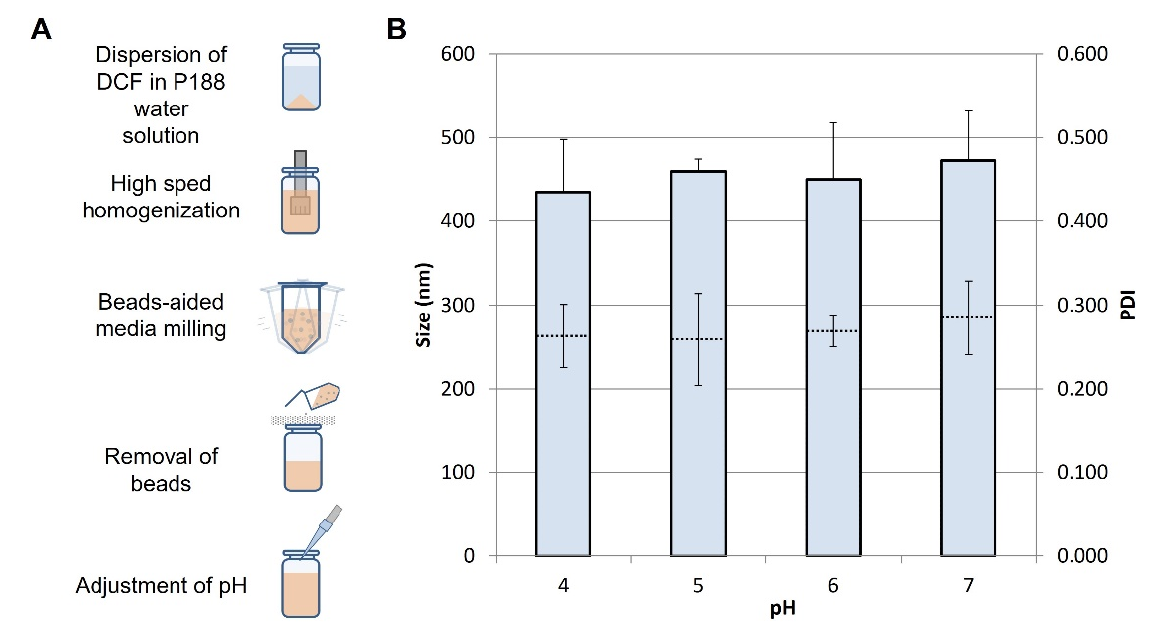
Figure 1. ( A ) Schematic of the preparation method of DCF NS. ( B ) Z average (full bars) and PDI (dotted lines) of DCF NS after pH adjustment at the value reported in the x axis. Values represent the average ± standard deviations of n = 3 replicates.